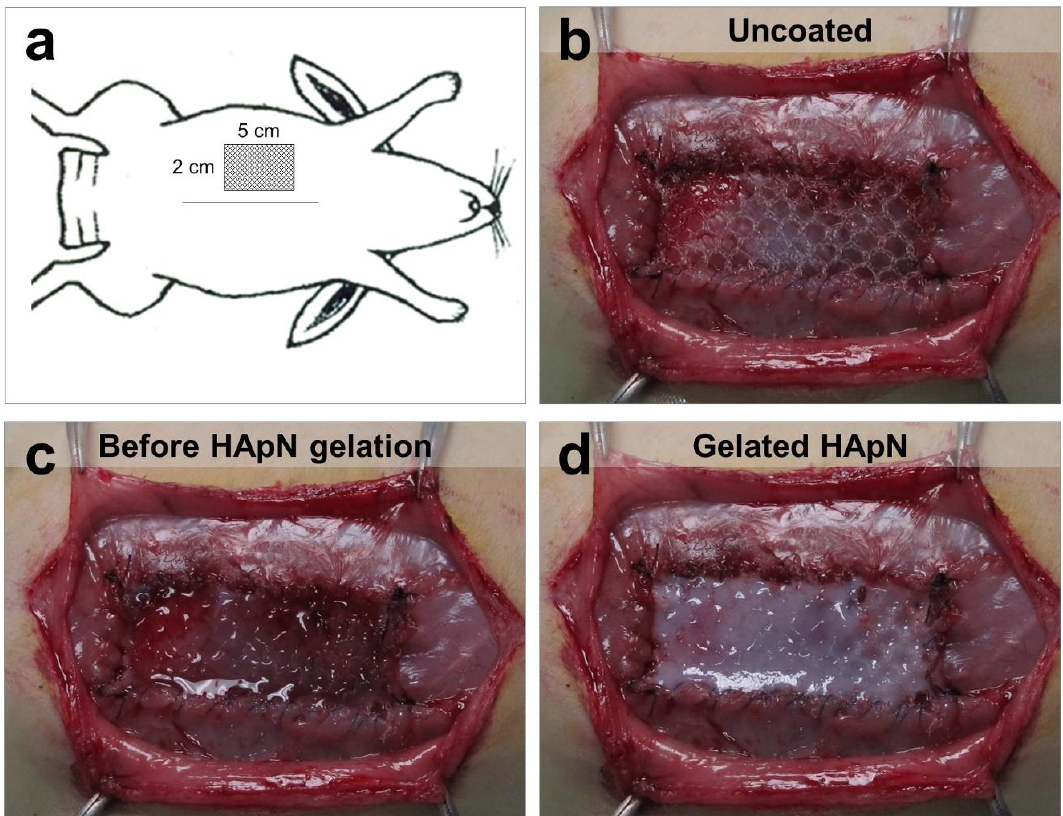
Figure 1. In vivo mesh coating procedure. ( a ) Diagram illustrating the surgical procedure. ( b ) Detail of an implanted mesh. ( c ) Immediately following implantation, the mesh was coated with the corresponding HApN or Rif-HApN hydrogel. ( d ) The hydrogel gelation was triggered using an infra-red lamp for few seconds.